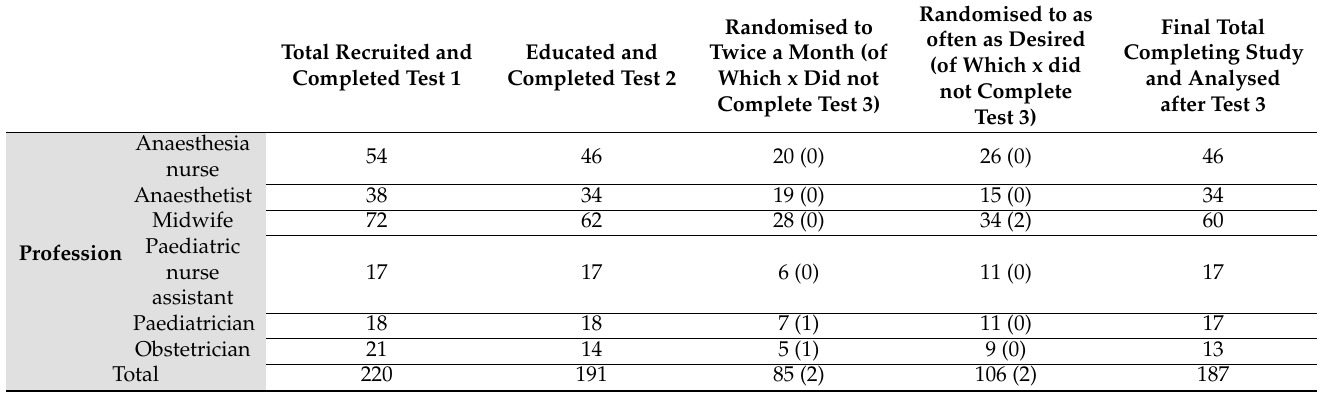
Figure 1. CONSORT flow chart for participants in the randomised controlled study. Table 1. Participants from six professional groups and their progression through the study.